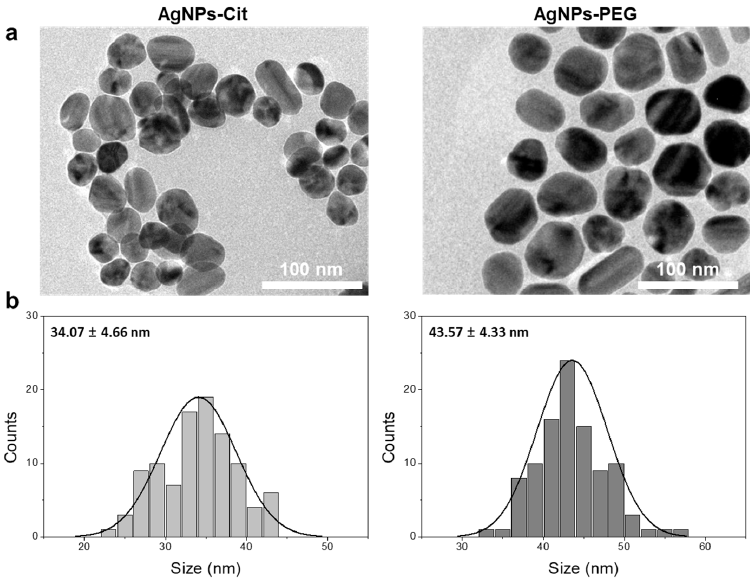
Figure 2. Characterizations of AgNPs-Cit and AgNPs-PEG. ( a ) Transmission electron microscopic (TEM) image and ( b ) size distribution.